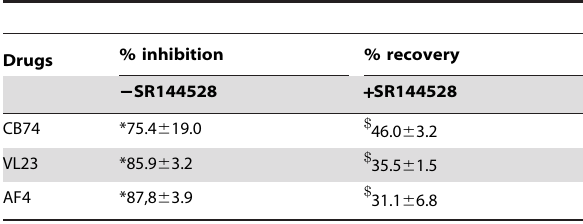
Table 1. CB2 mediated effects of 1,8-naphthyridine, pyridine and quinoline